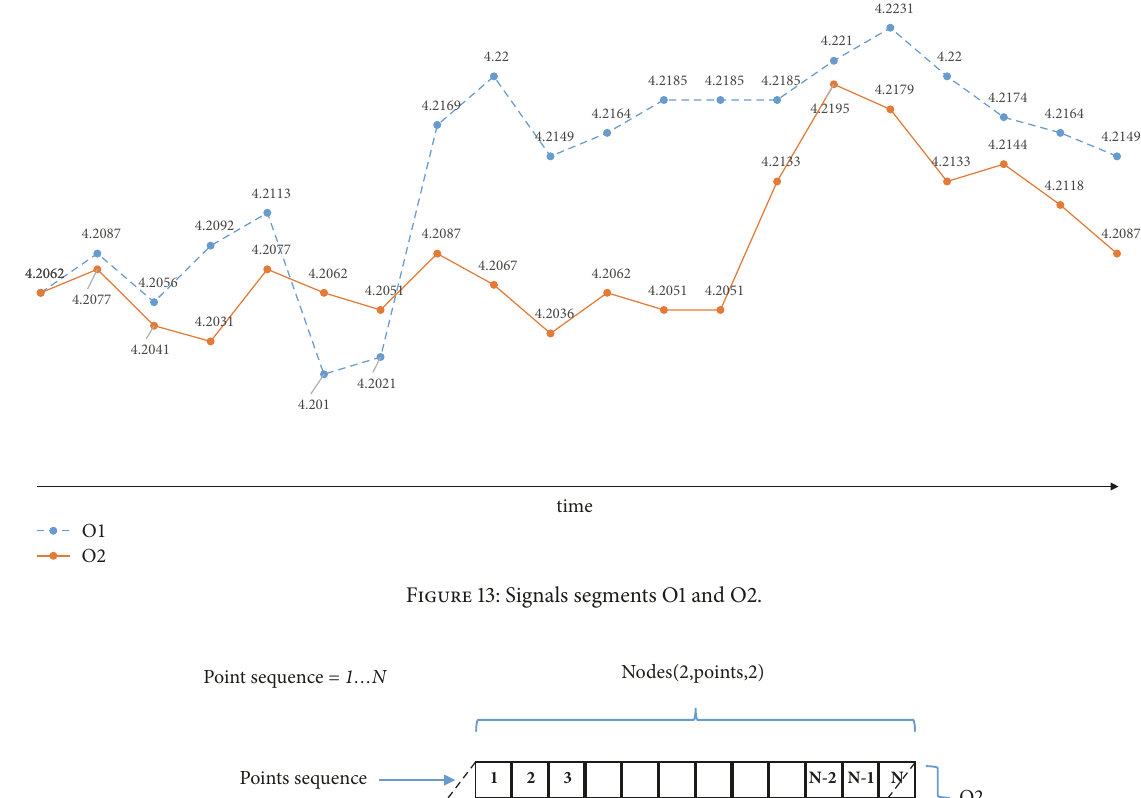
Figure 14: Node matrix.